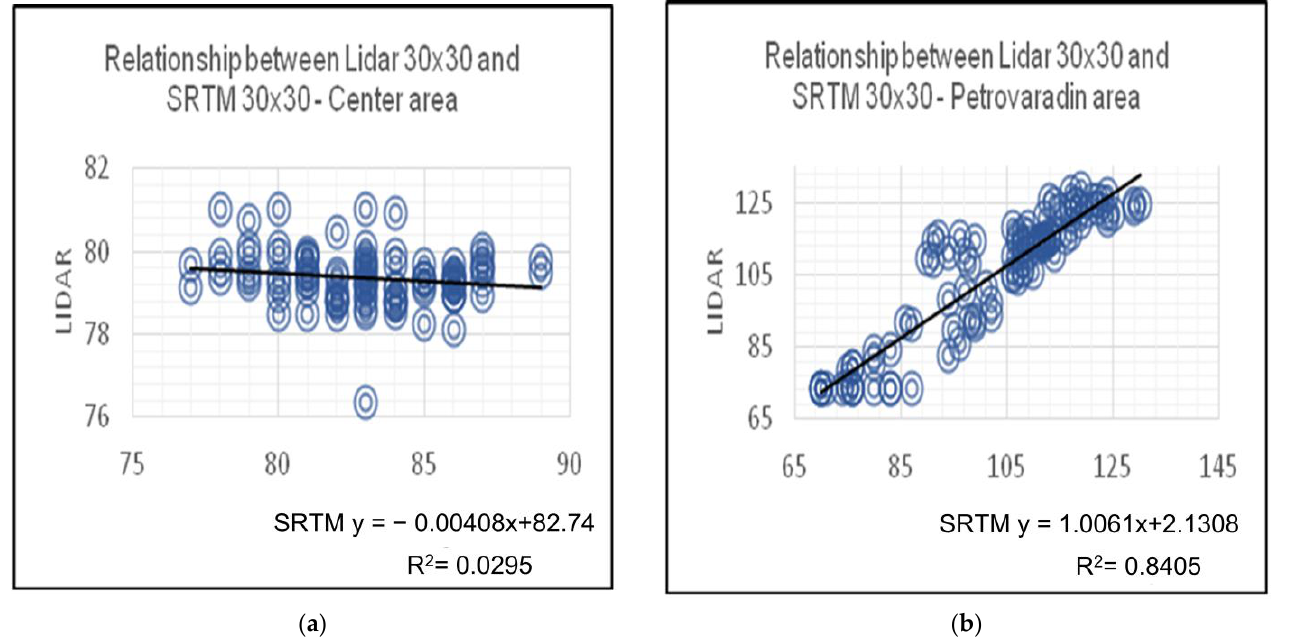
Figure 13. Linear regression of LiDAR and radar DEMs. ( a ) Linear regression based on the col- lected sample of the Center area; ( b ) Linear regression based on the collected sample of the Pe- trovaradin area.